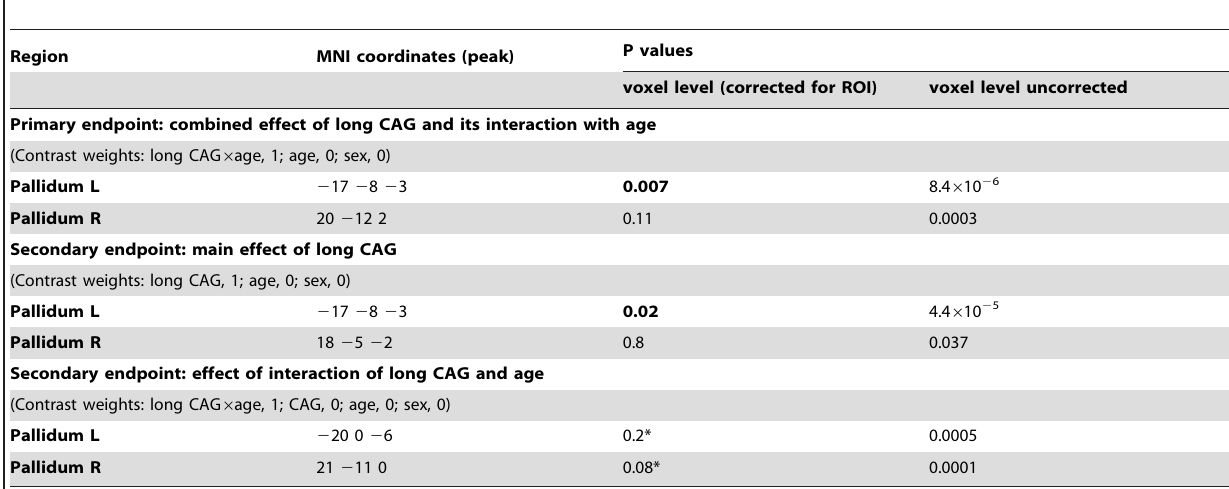
Figure 1. Projections of coronal (upper row) and axial (middle row) slices onto the SPM template as well as maximum intensity projections (lower row) are shown. MNI coordinates are indicated in the left upper corners. Increasing significance (T score) is color-coded from dark red to light yellow as indicated by the bar in the center. Note that only the clusters marked with a red rectangle contain peak voxels, which remained significant after correction for multiple comparisons at the voxel level. For better visibility, all results (including those from exploratory analyses) are shown at a height threshold of 0.01 uncorrected. Cluster sizes were restricted to 20 contiguous voxels for ROI analyses or subjected to cluster level correction (p , 0.05 corrected) for the whole brain analysis. A) Combined effect of long CAG & its interaction with age, ROI analysis (left) and whole-brain analysis (right) revealing one bilateral cluster reaching from the pallidum across parts of the ventral thalamus to the midbrain (corrected P value at the cluster level, 0.003). B) Main effect of the long CAG, ROI analysis. C) Interaction analysis of long CAG with age, ROI analysis. doi:10.1371/journal.pone.0029809.g001 Table 1. Influence of long CAG and age on cerebral gray